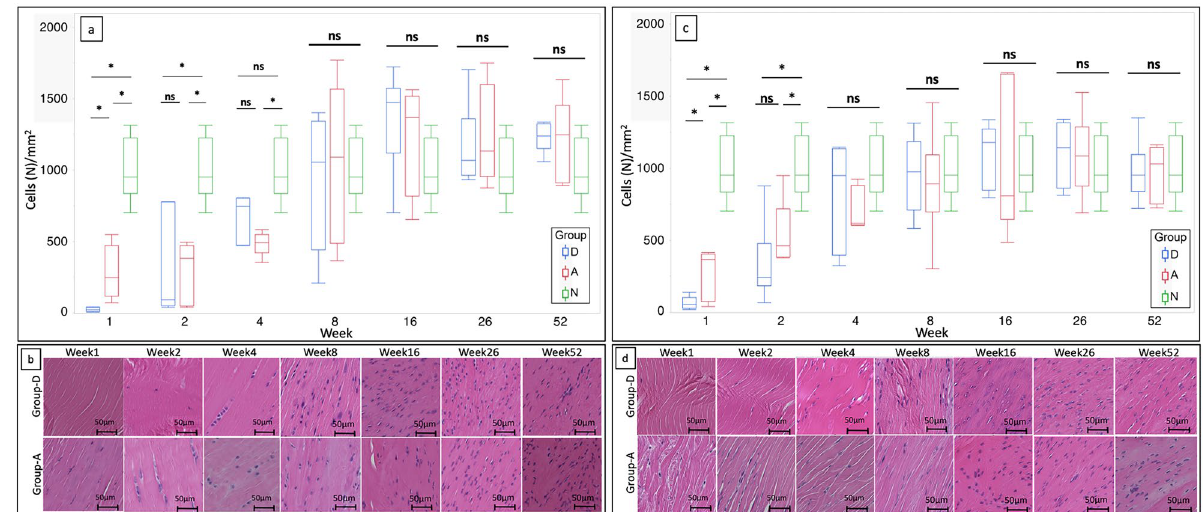
Figure 3. Comparison of the cellularity of the decellularized bovine tendon and autologous tendon in rat ACL reconstruction for up to 52 weeks of implantation. ( a ) Box plots depicting the count of cells in the intra-articular grafts of groups D and A at each time point. The number of cells in native ACL are shown as group N (n = 6, for each period in each group). ( b ) Representative hematoxylin–eosin staining showing cell infiltration in the intra-articular graft at various time points in groups D and A. ( c ) Box plots showing the count of cells in the intratibial tunnel grafts of groups D and A at each period. The number of cells in native ACL are shown as group N. (n = 6, for each period in each group). ( d ) Representative hematoxylin–eosin staining showing cell infiltration in the intratibial tunnel graft at various time points in groups D and A. ACL anterior cruciate ligament, group D decellularized bovine tendon graft, group A autologous tendon graft, group N native ACL, *statistically significant (p < 0.05), ns not statistically significant.